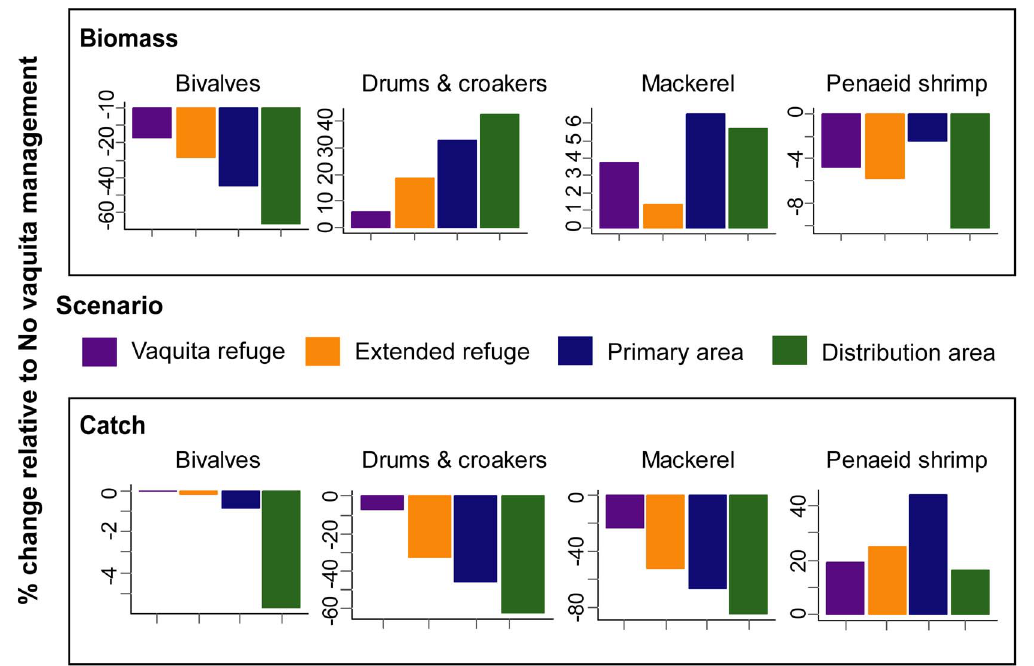
Figure 4. Biomass (top panel) and incidental catch (bottom panel) for priority target species under various management scenarios. Bars show percent change relative to the No vaquita management scenario, relative to 2038 for biomass and to 2009 for catch.